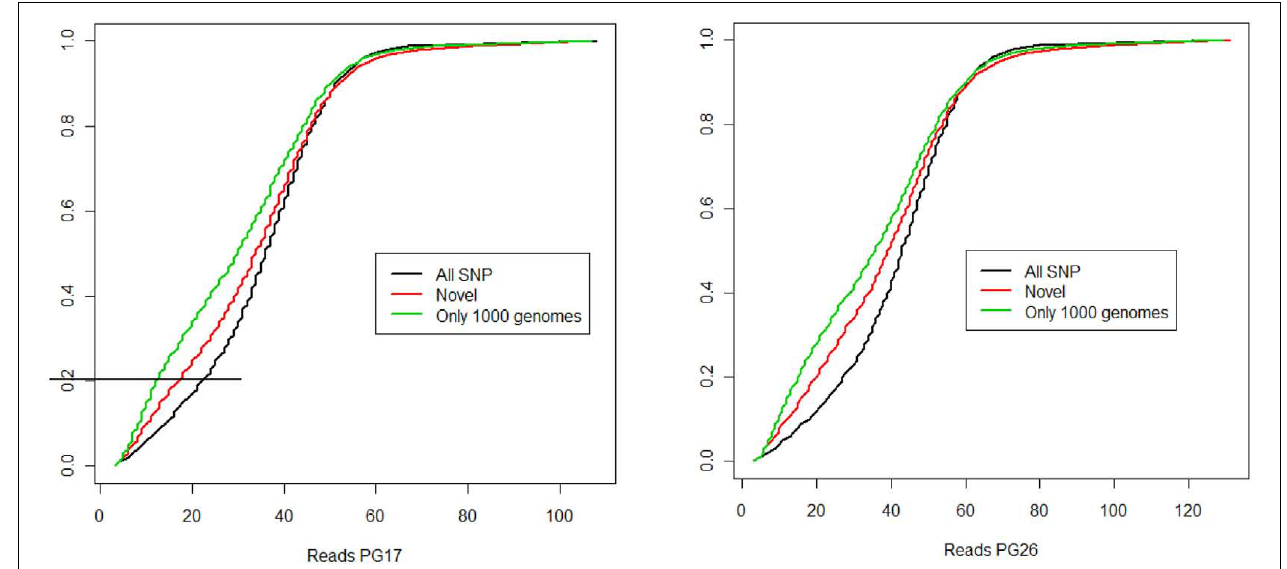
FIGUREA6 | Cumulative distributions of depth. The plots show the cumulative distributions of SNPs with coverage < values in the x -axes. For example, 80% of the reads in PG17 have more than 20-fold coverage.